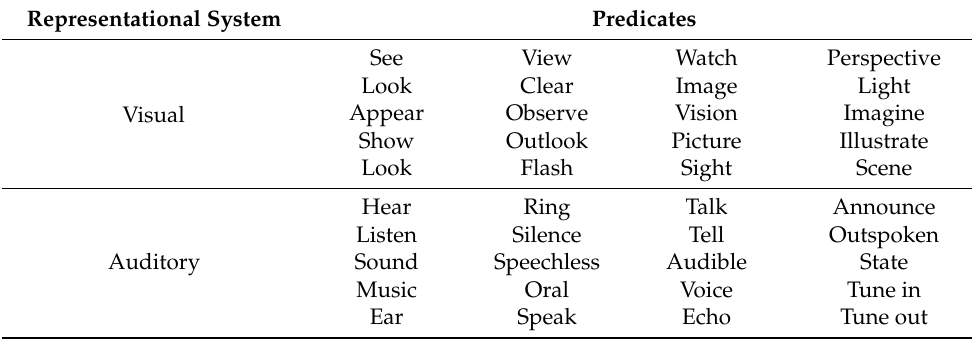
Table 1. Example of key predicates for each representational